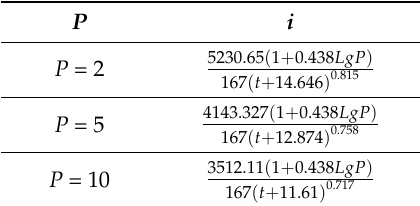
Table 2. Design rainfall intensity i (mm/min) of Guangzhou in different rainfall return periods, P (years) [38].